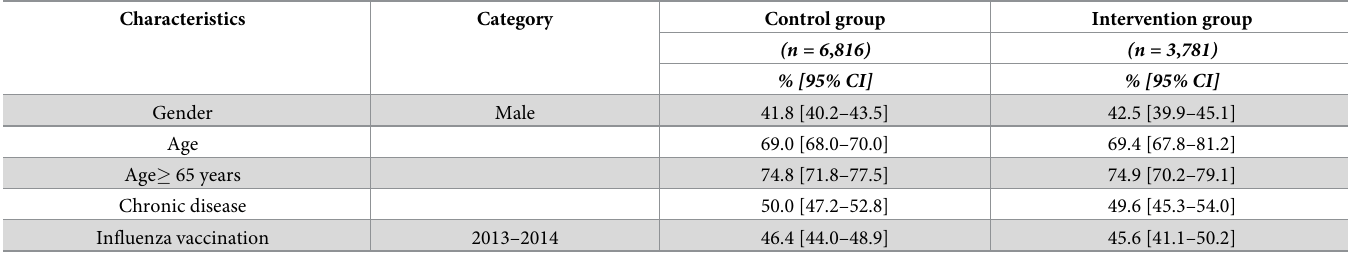
Table 1. Baseline characteristics (October 2013-February 2014) by study condition.